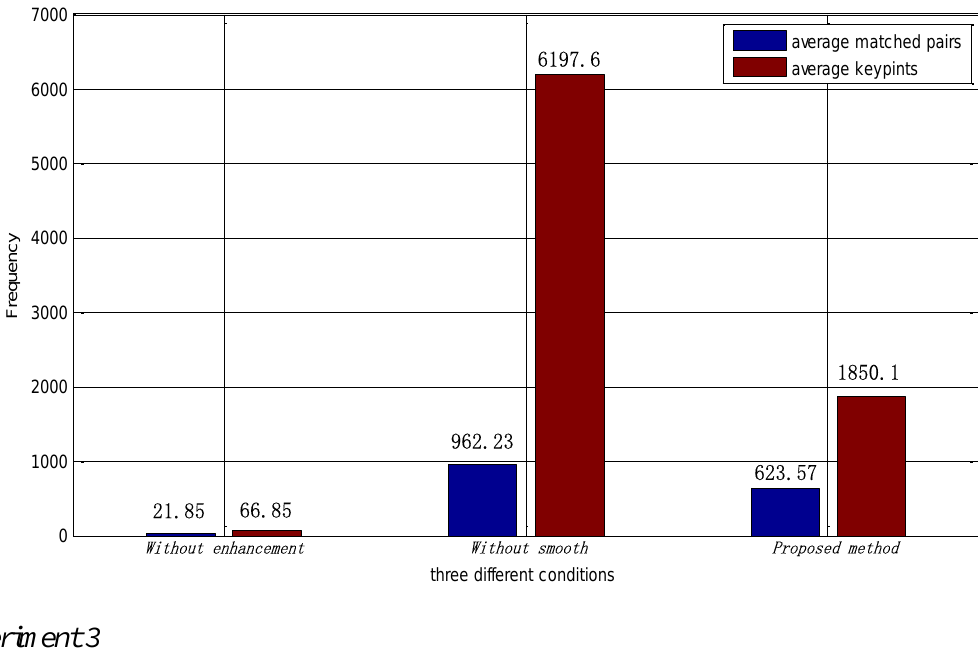
Figure 12. Keypoints